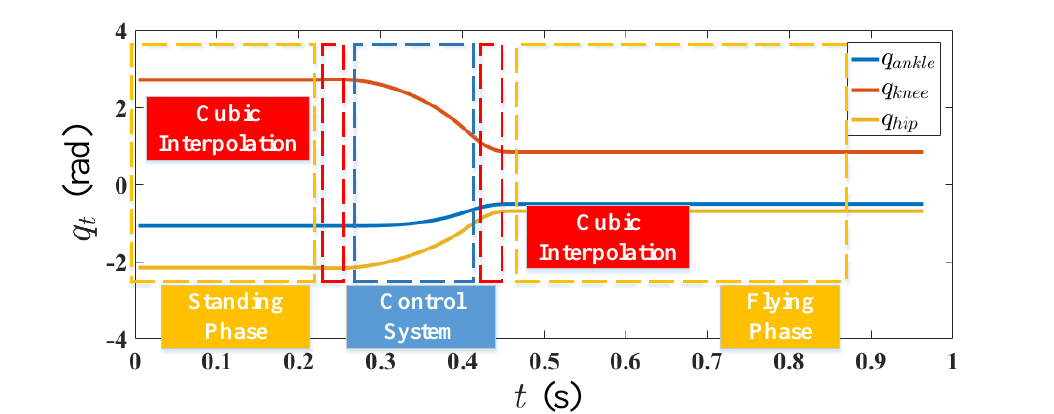
Figure 12. The trajectory of each joint during the simulation.